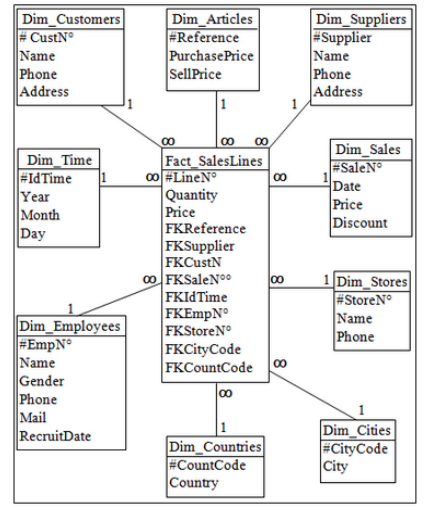
Fig. 5. The star model for the fact « Sales Lines »